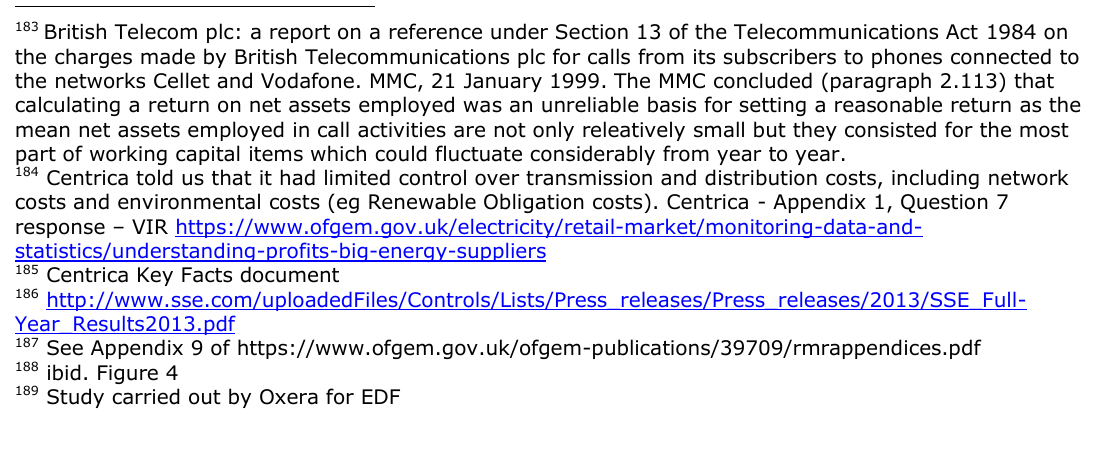
ibid. Figure 4 189 Study carried out by Oxera for